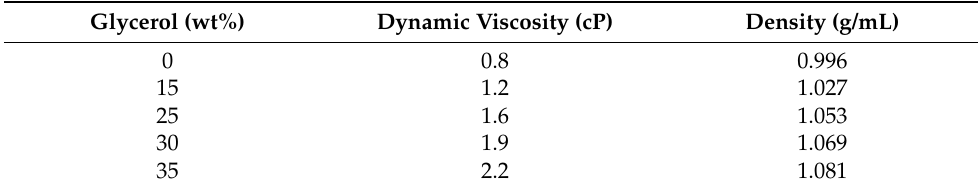
Table 6. Five test solutions used in the capillary suction tests with their associated dynamic viscosities and densities at 30 ◦